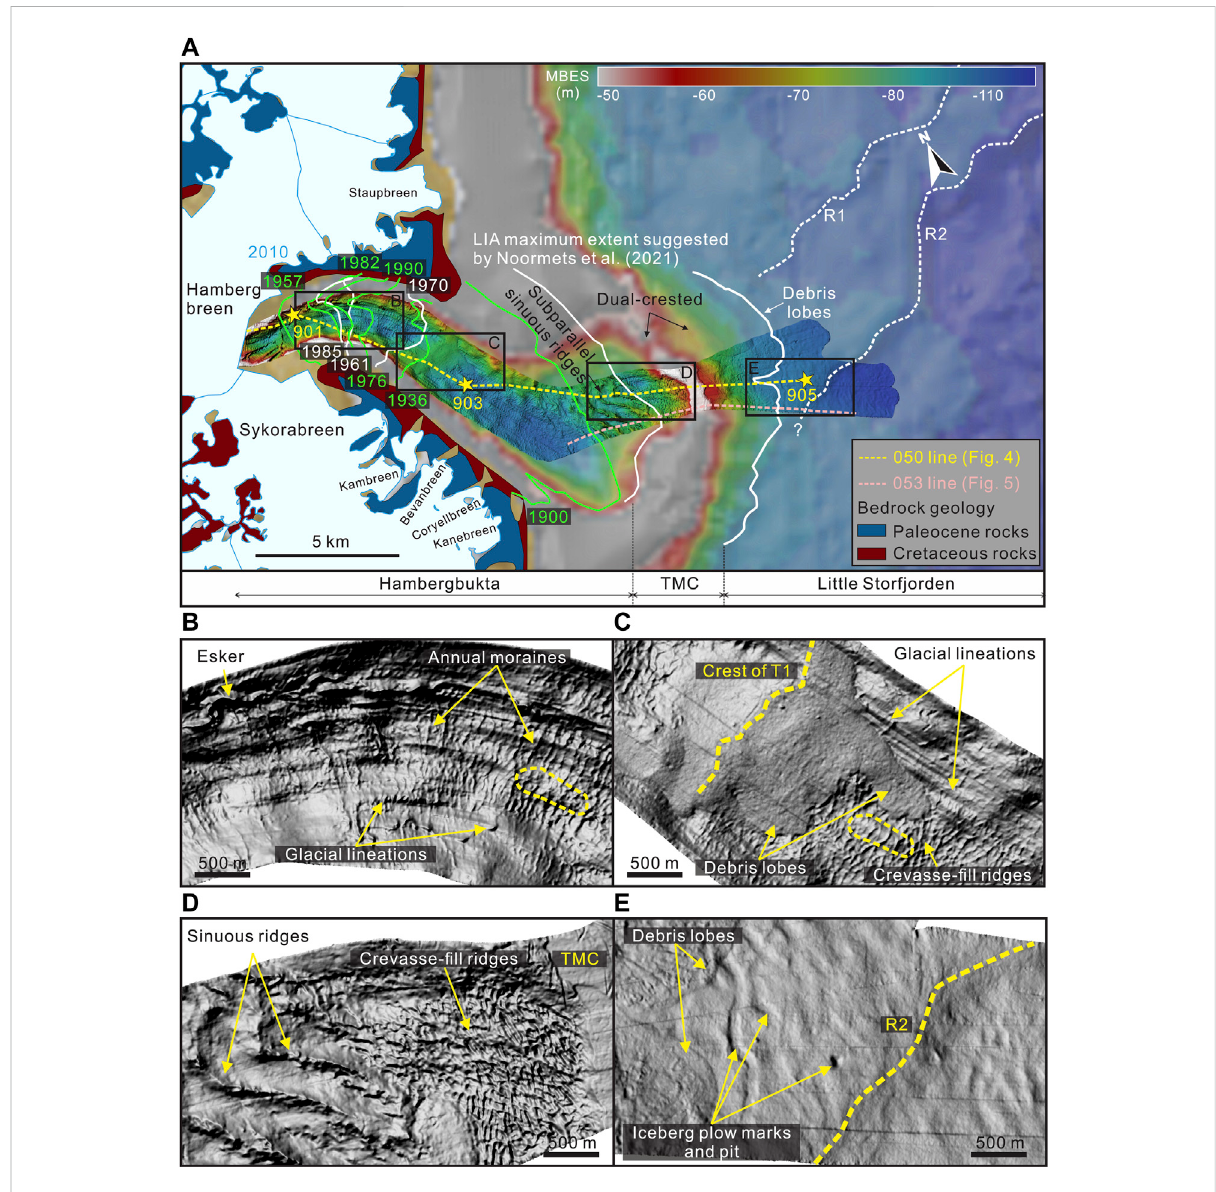
FIGURE 3 (A) Swath-bathymetry of Hambergbukta and its downslope area (Little Storfjorden). Three yellow stars indicate the locations of the studied cores. Yellow and pink dotted lines are sub-bottom pro fi ling (SBP) track lines. For the glacier extent in 2010, we used a shape fi le of the 2001 – 2010 glacier area (König et al., 2013). The glacier fronts between 1900 and 1990 are based on Lefauconnier and Hagen (1991) and Noormets etal.(2021).Onthedistalsideoftheterminalmorainecomplex(TMC),thewhitesolidindicatestheextentofdebrislobes(referredtoNoormets et al., 2021), whereas the dotted lines mark the locations of the NE-SW-oriented ridges (R1 and R2). Bedrock geology surrounding Hambergbukta was referred to Dallmann (2014). Panels (B) to (E) show high-resolution sea fl oor morphologies. (B) Annual moraine subparallel to the former glacier front. (C) A tongue of the debris lobe extending from the terminal moraine (T1), partly covering former crevasse- fi ll ridges and glacial lineations. The crest of T1 was referred to Noormets et al. (2021). In panels (B) and (C) , yellow dashed circles indicate drumlins. (D) Sinuous ridges and crevasse- fi ll ridges on the proximal fl ank of TMC. (E) The downslope area (Little Storfjorden) from the TMC shows the outer part of R2 and iceberg plow marks and